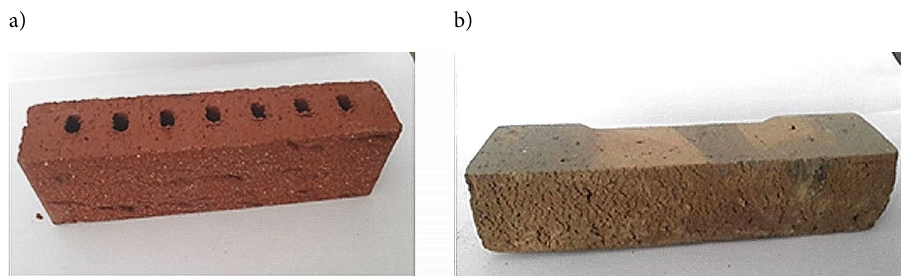
Figure 2. Ceramic veneer bricks: a – perforated (P), b – solid (S)